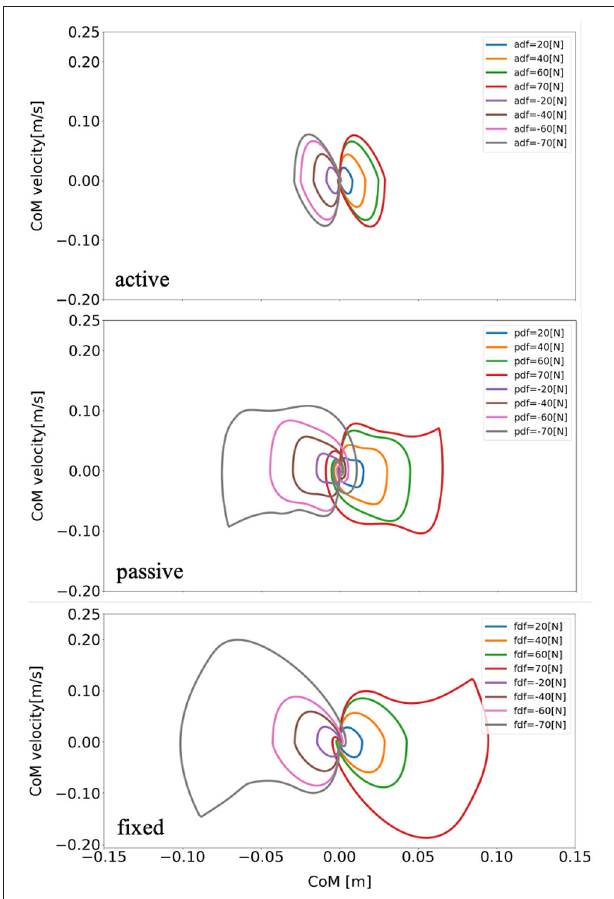
FIGURE 6 | Evolution of the center of mass phase portrait of the model for three different arm states (active arm, passive arm, fixed arm) for different disturbing forces: (1) Push backward: − 20 [ N ], − 40 [ N ], − 60 [ N ], and − 70 [ N ]. (2) No force: 0 [ N ]. (3) Push forward: 20 [ N ], 40 [ N ], 60 [ N ], and 70 [ N ]. “a,” “p,” and “f” in the labels “adf,” “pdf,” and “fdf” represent the cases with active arms, passive arms, fixed arms, respectively, and “df” represents the disturbing